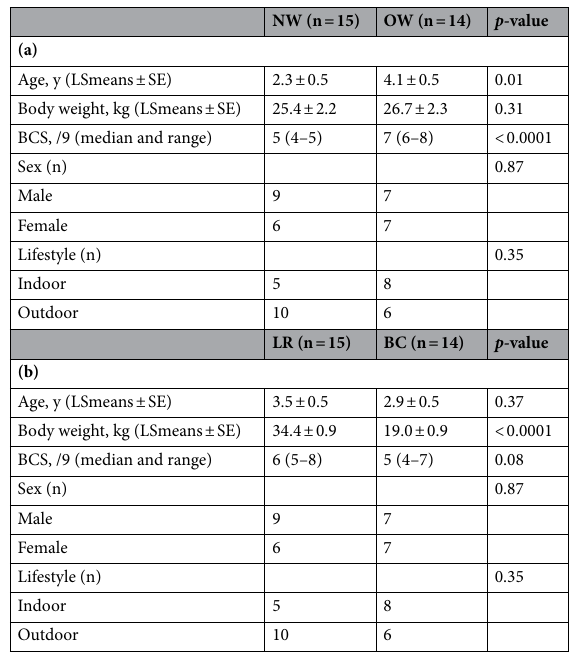
Table 1. Demographics of the dogs enrolled in this study (n = 29). Statistical analyses were carried out to compare dogs based on body condition (a) and breed (b). BCS, body condition score; NW, lean dogs; OW, overweight dogs. BCS, body condition score; BC, Border Collies; LR, Labrador